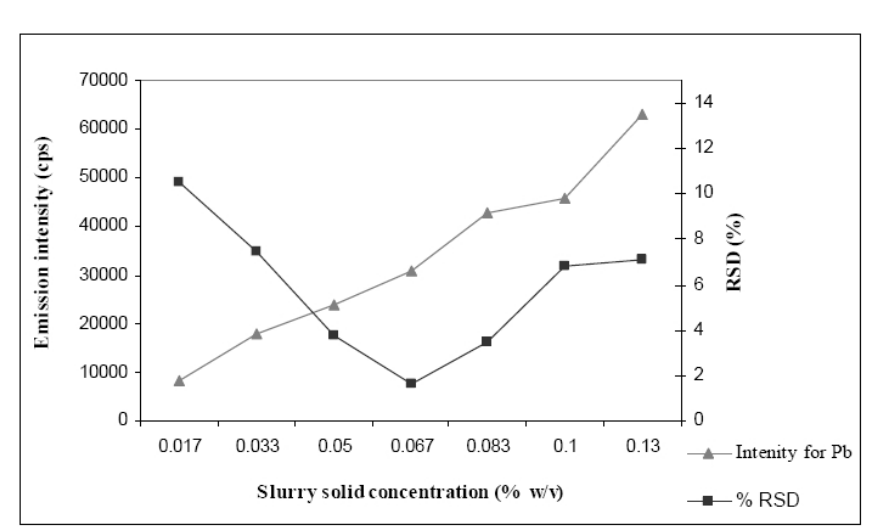
Fig. 2 Pb signal and precision during slurry nebulization ICP-OES.